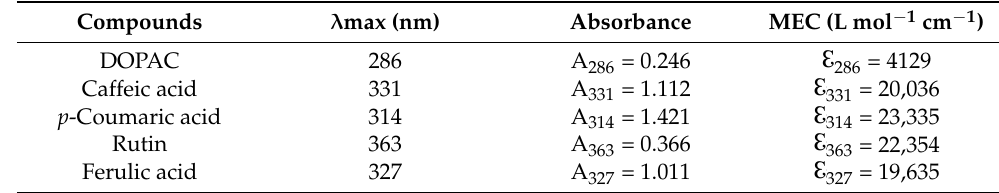
Table 1 . Molar extinction coefficient (MEC) and maximum wavelength of the tested compounds at 10 µg/mL.